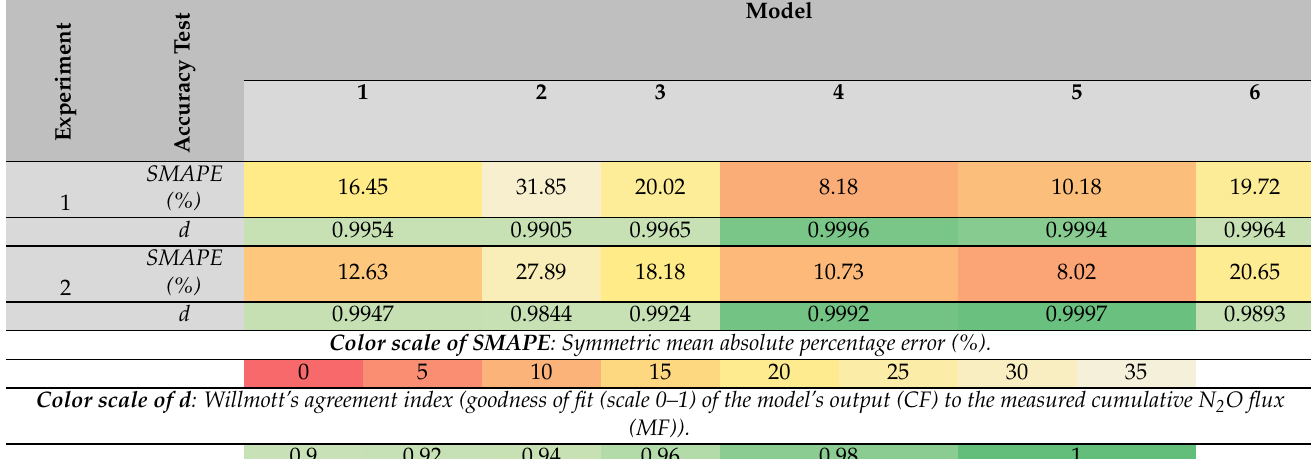
Table 1. Results of the accuracy tests conducted for CFcu with all models with MFcu .